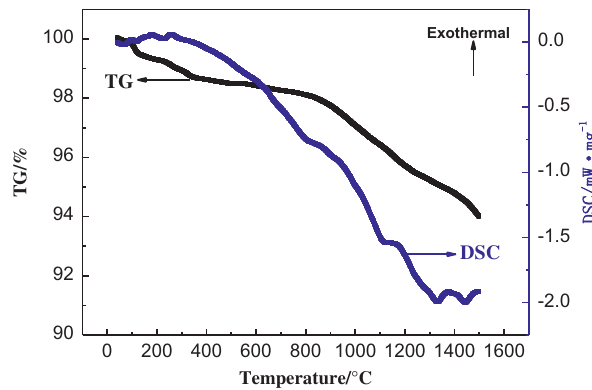
Figure 5: TG-DSC curves of the carbon materials obtained by carbonization treatment at 1,200°C in air flow at a heating rate of